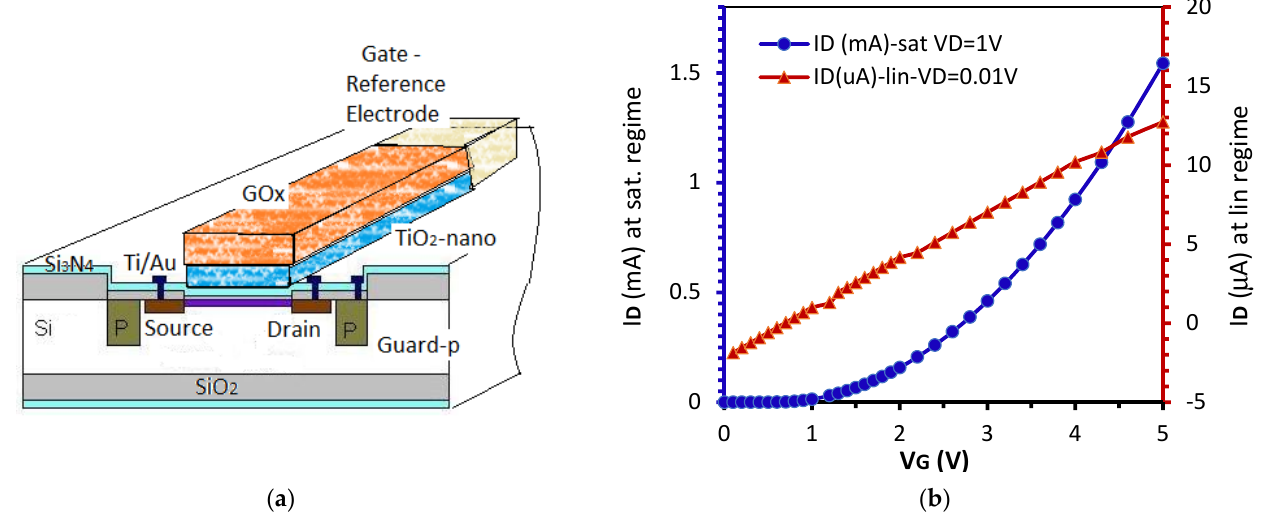
Figure 3. ( a ) Structure of the ENFET glucodetector, and ( b ) measured transfer characteristics in the glucose absence.